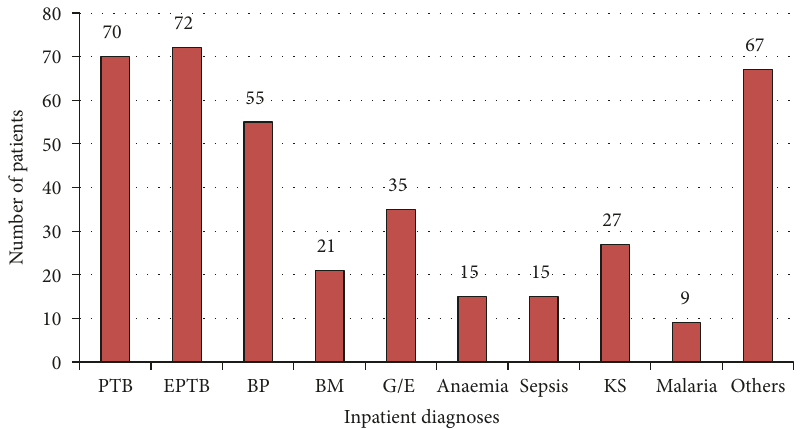
Figure 2: Histogram showing the most common diagnoses among HIV-infected adults hospitalized at Mulago hospital. PTB, pulmonary tuberculosis; EPTB, extra pulmonary tuberculosis; BP, bronchopneumonia; BM, bacterial meningitis; G/E, gastroenteritis; KS, Kaposis sarcoma, and others included PCP, HIV associated nephropathy, toxoplasmosis, acute hepatitis, and recurrent pleural effusions. 74 patients with Cryptococcal meningitis were excluded from the study .